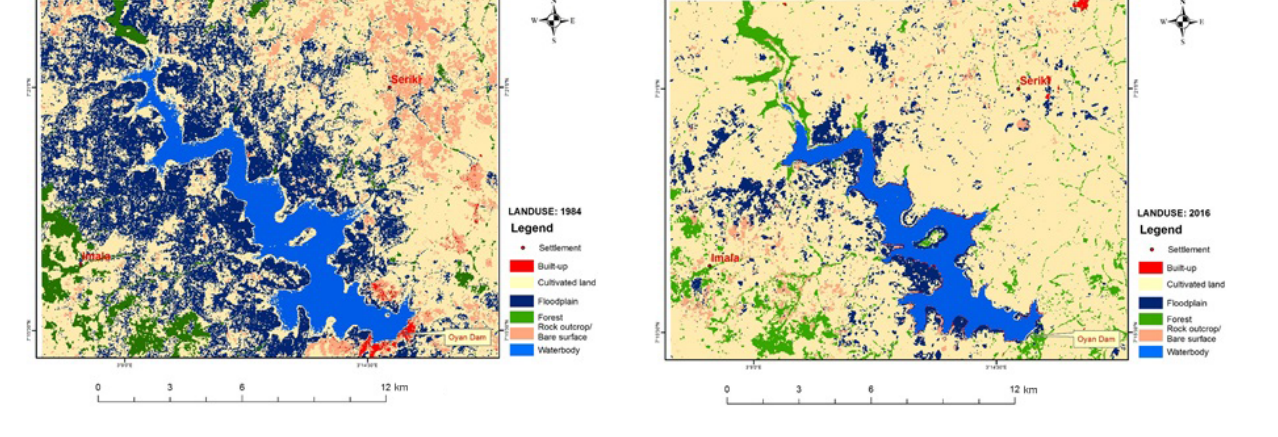
Figure 5. Landuse Pattern of Oyan Dam in 1984 and